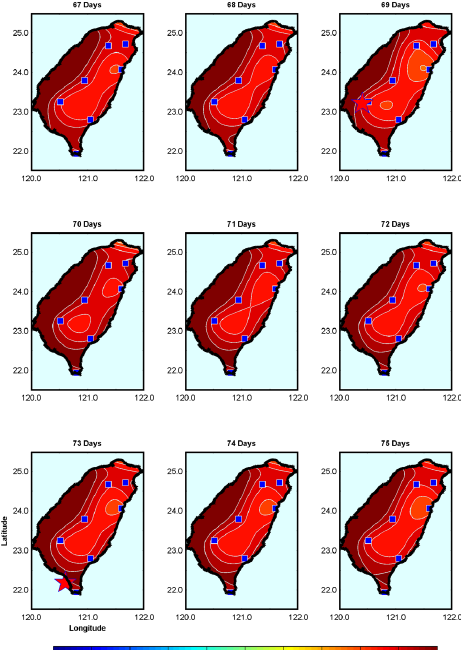
Fig. A4. A contour map of the cross correlation values from nighttime data during EQ7 and EQ8 (the red